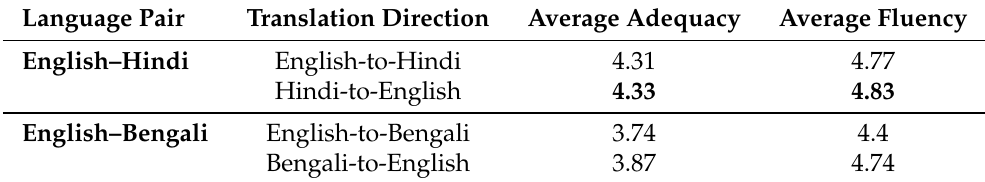
Table 6. Results of manual